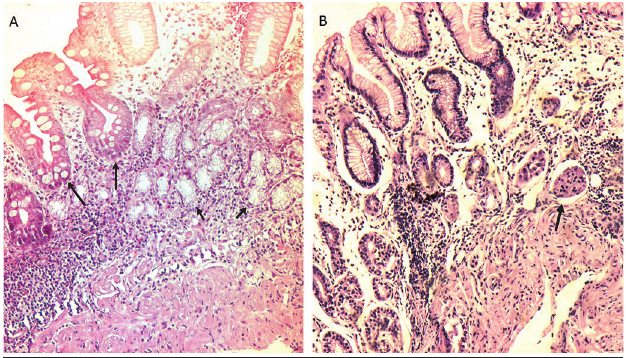
FigurE 2 − Severe atrophy of the body mucosa presenting in: A) areas of intestinal metaplasia (long arrows) and of PSA (short arrows); B) endocrine-like nodules immersed in lamina propria (arrow). This latter finding is indicative of mucosa atrophy associated with autoimmune disease. HE, original magnification 100× PSA: pseudoantral metaplasia; HE: hematoxylin and